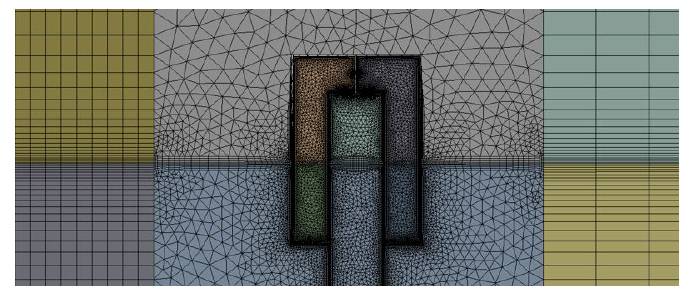
Figure 6. Mesh in the vicinity of the